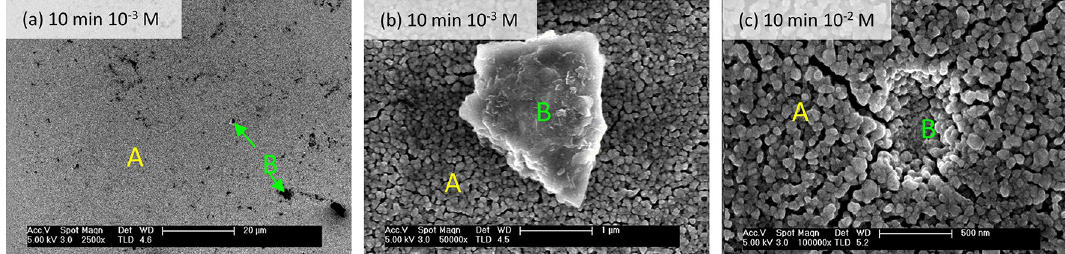
Figure 3. Homogeneous and heterogeneous damages (regions labelled A and B, respectively) in LCO thin films caused by exposures to oxalic acid. Scale bars correspond to: ( a ) 20 μm, ( b ) 1 μm and ( c ) 500 nm. Figure created with WSxM 5.0 Develop (http:// www. wsxm. es) 15 .